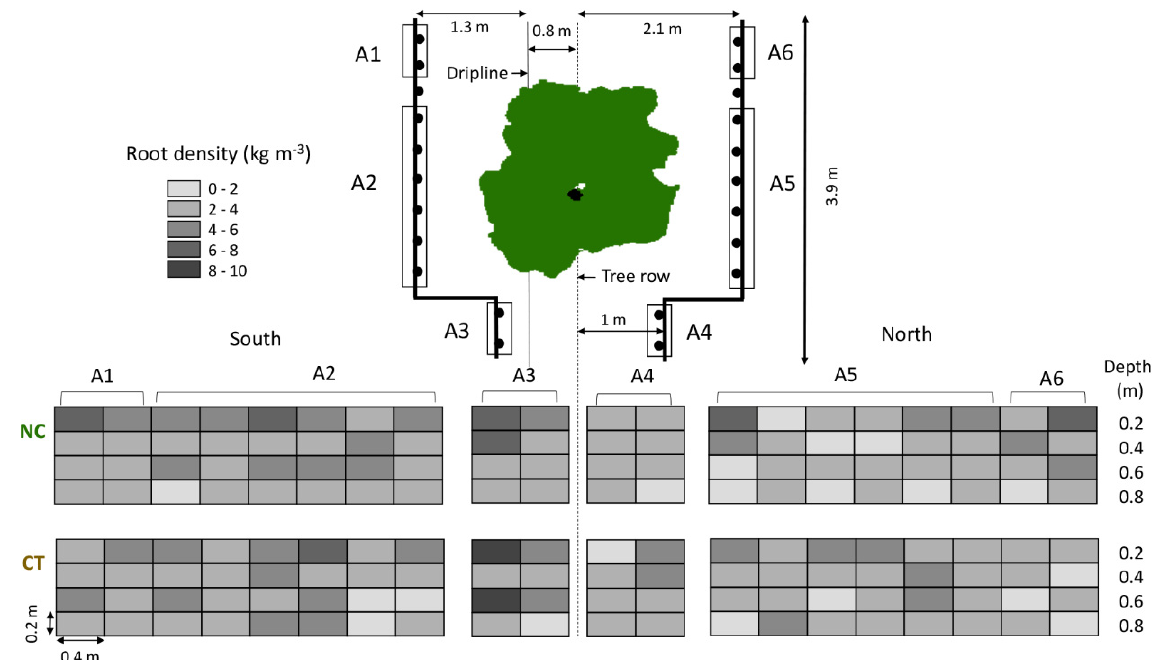
Figure 2. Root distribution of olive trees subjected to two different soil management systems (Natural grass cover, NC; Conservative tillage, CT). Different codes identify the characteristic positions with respect to the tree and tree row. A1 and A6, inter-row and inter-tree positions in the south and north trenches, respectively; A2 and A5, inter-row and frontal tree positions in the south and north trenches, respectively; A3 and A4, close to the tree row (1 m) and inter-tree positions in the south and north trenches, respectively. The range of root density in each square represents the average of three replicate trenches for each treatment.